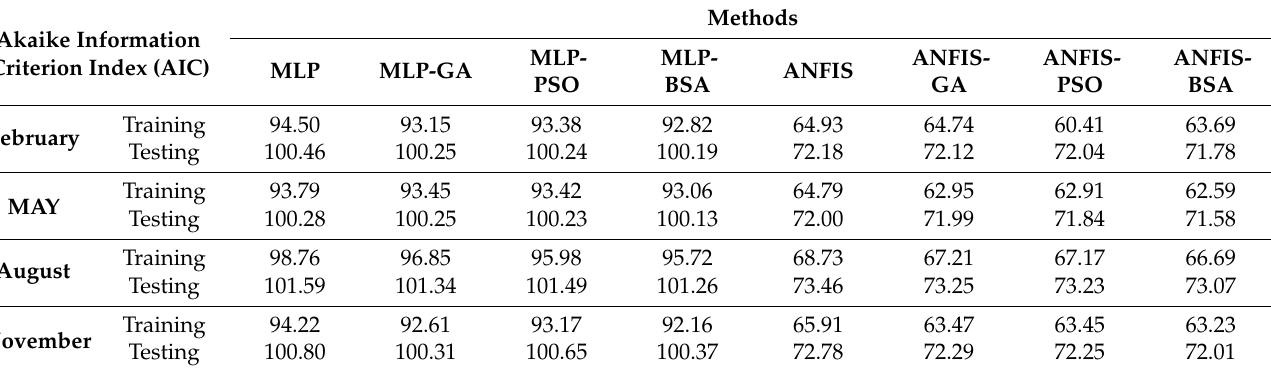
Table 9. Comparison of different models based on the AIC index for different